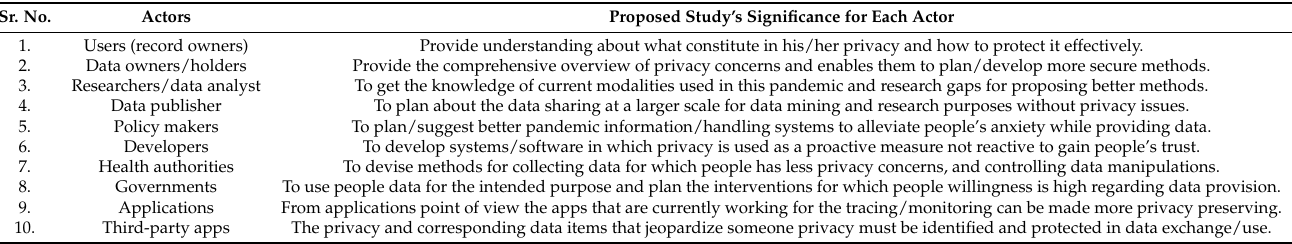
Table 2. Significance of the proposed study for different